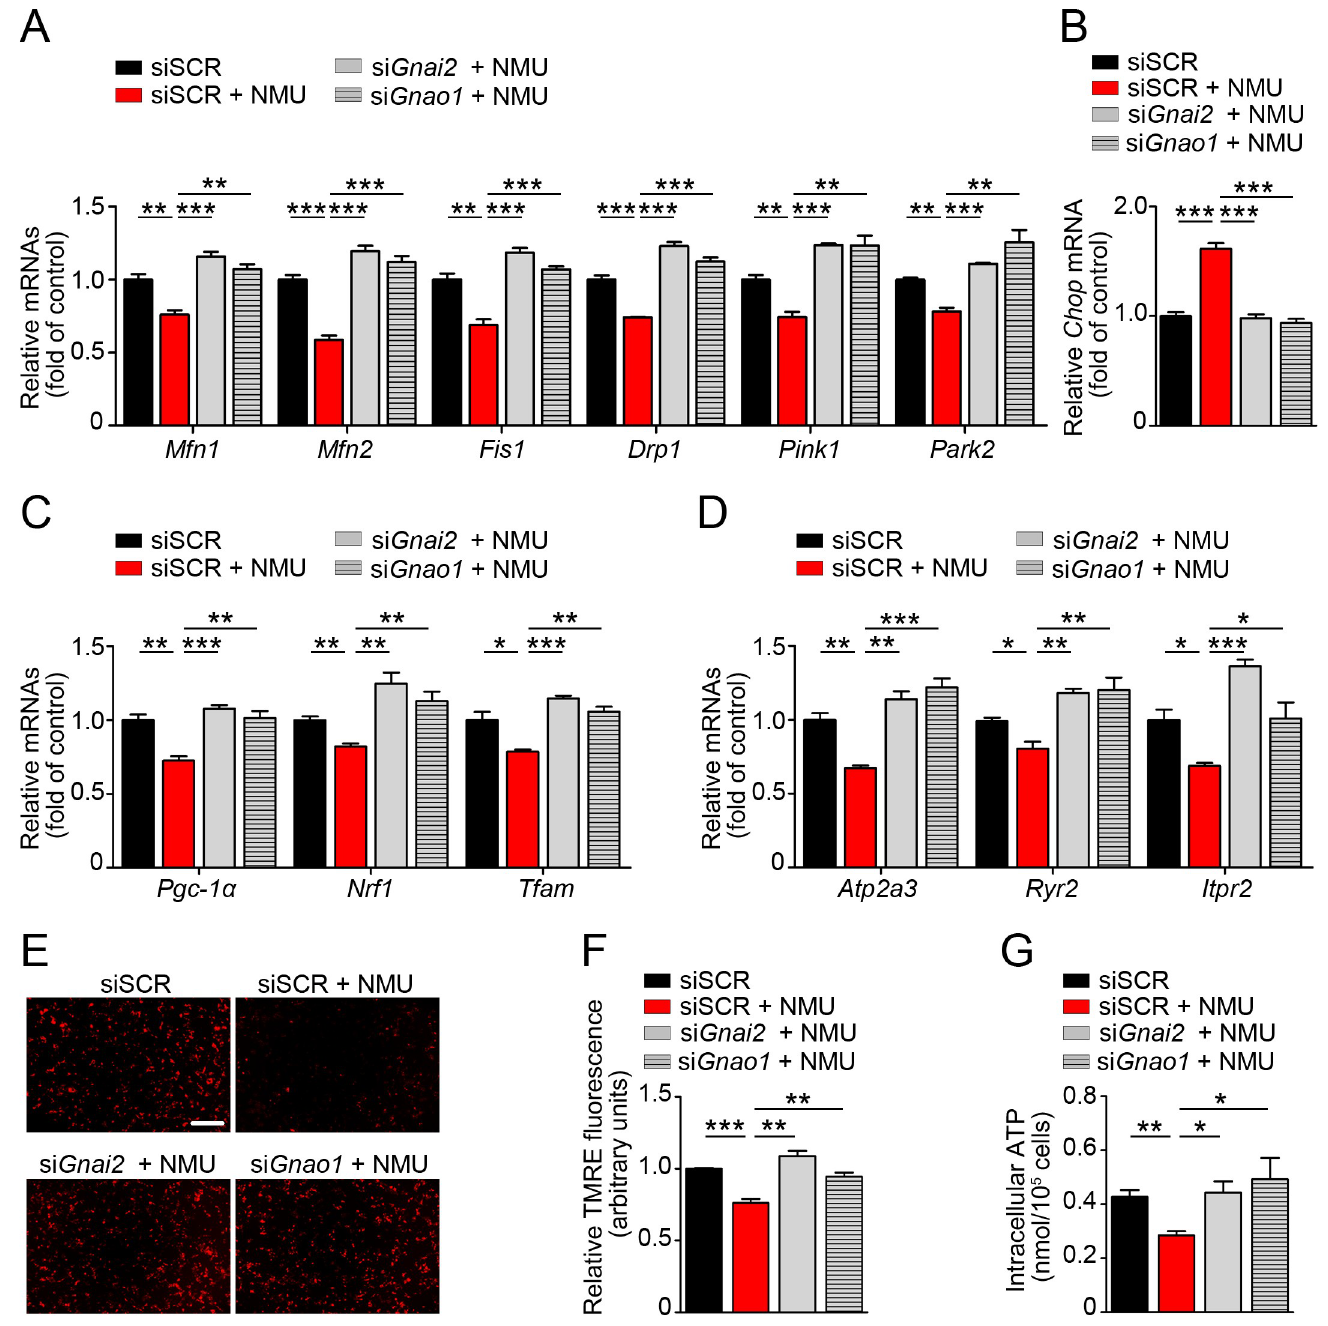
Fig 4. Effects of Gnai2 and Gnao1 knockdown on NMU-induced alterations related to mitochondrial function and ER stress in MIN6-K8 cells. (A) mRNAs related to mitochondrial dynamics (n = 4). (B) Chop mRNA (n = 4). (C) Pgc-1 α , Nrf1 , and Tfam mRNAs (n = 4). (D) Atp2a3 , Ryr2 , and Itpr2 mRNAs (n = 4). (E, F) Mitochondrial membrane potential determined by TMRE staining (n = 4). (G) Intracellular ATP level (n = 4). � P < 0.05, �� P < 0.01, ��� P < 0.001. https://doi.org/10.1371/journal.pone.0250232.g004 the downstream signal transduction of NMUR1 in β cells has not been elucidated. In this study, we showed that NMUR1 in β cells uses G α signaling to mediate the detrimental effects i/o of NMU on insulin secretion. Upon NMU binding, NMUR1 preferentially activates G α and i2